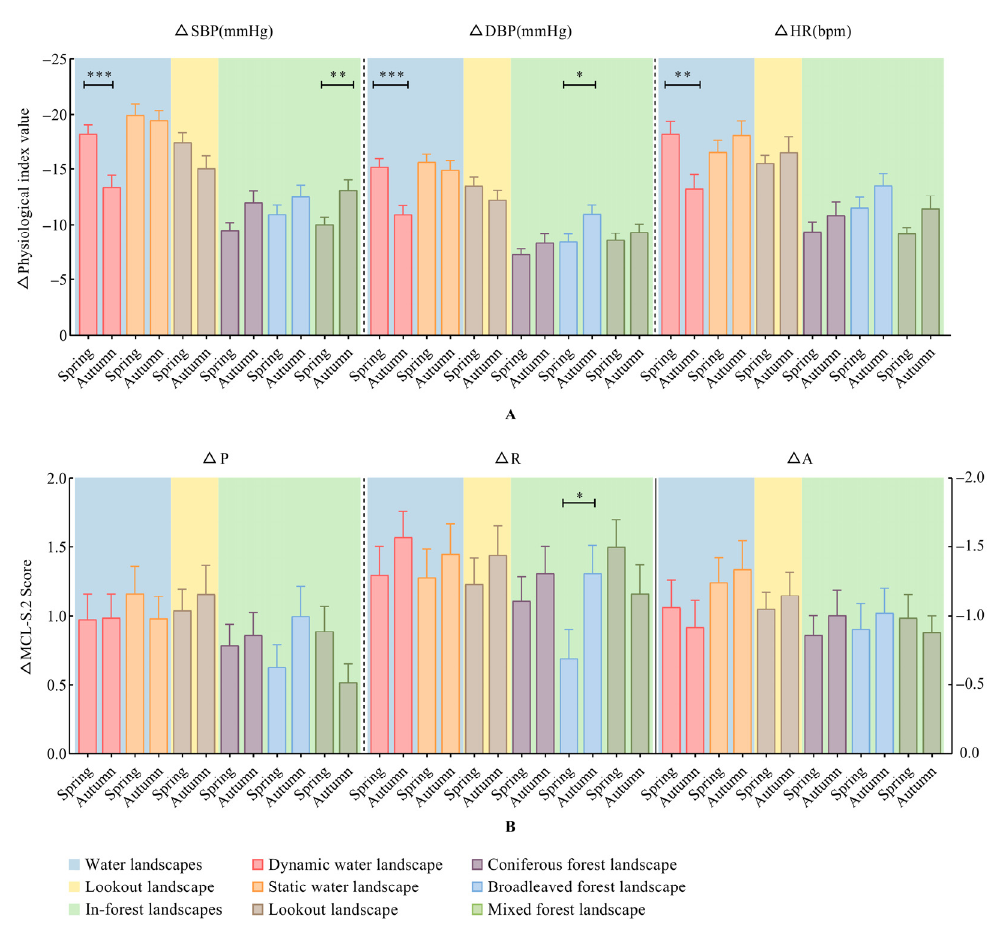
Figure 4. Seasonal differences in physiological and psychological index variation across recreation spaces. ( A ) Physiological indexes. ( B ) Psychological indexes. Mean ± SE; * p < 0.05; ** p < 0.01; *** p < 0.001; Independent-samples t test. Δ D = post–pre. SBP: systolic blood pressure; DBP: diastolic blood pressure; HR: heart rate; P: pleasantness; R: relaxation; A: anxiety. This figure was created by Rui Chen.